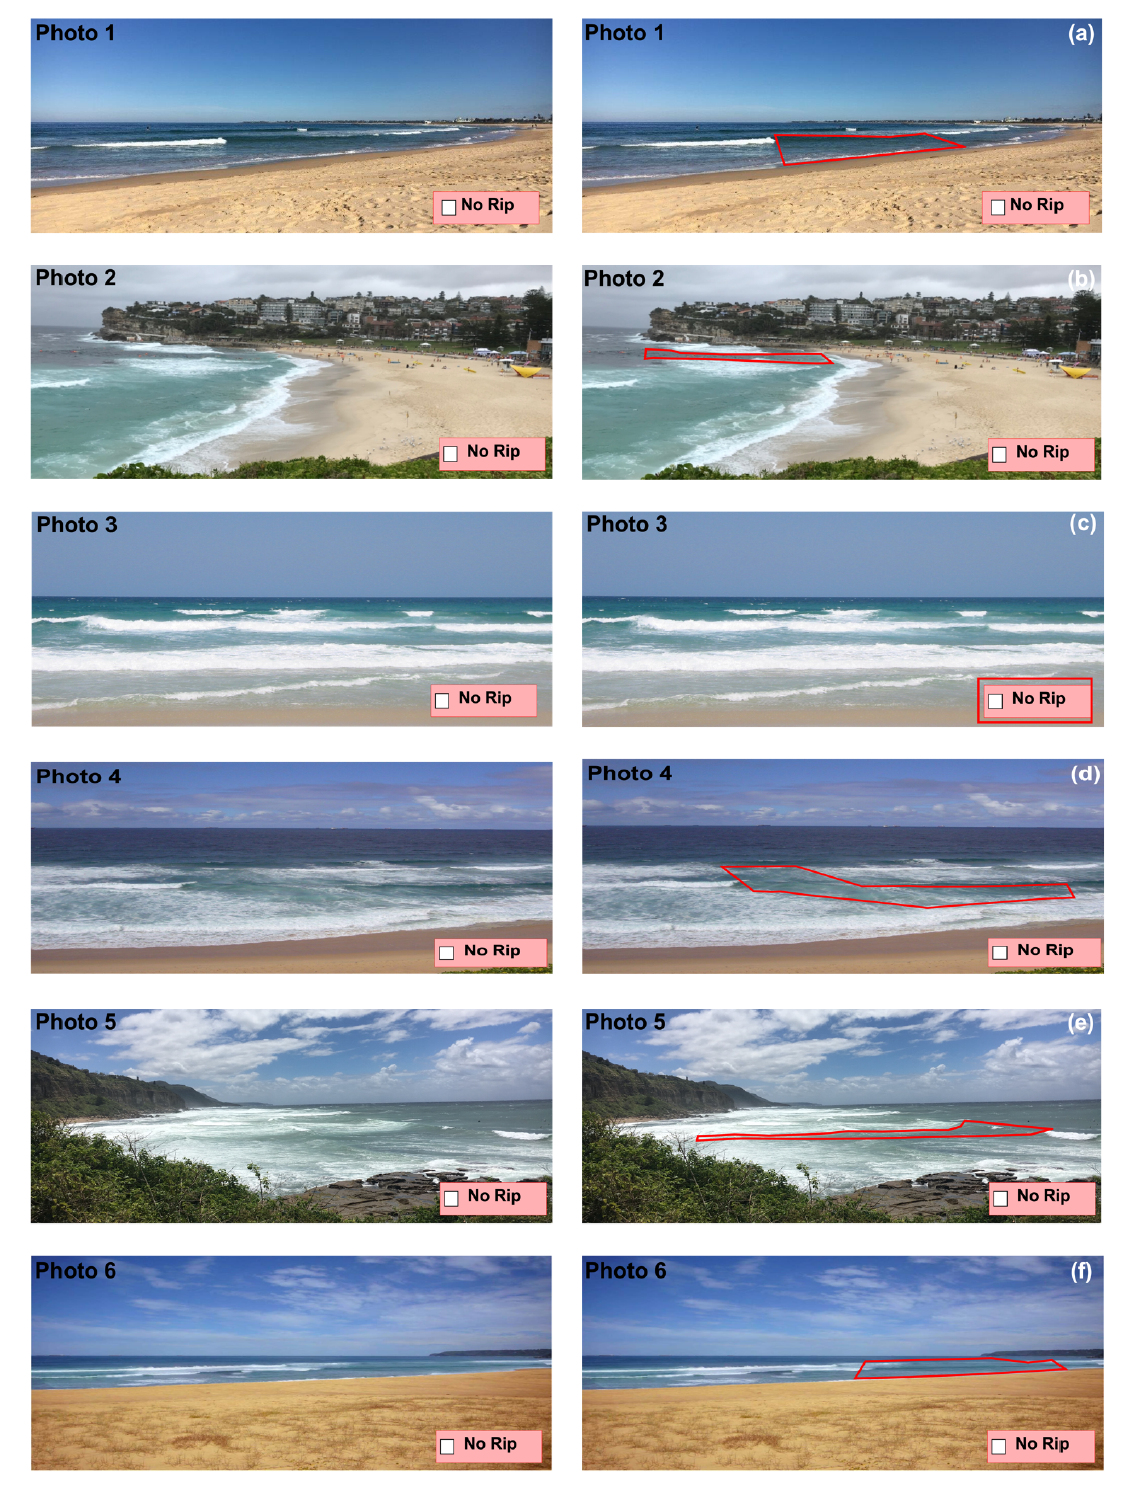
Figure 6. Images that were used to assess beachgoers’ ability to identify rip currents in photos. The polygons on the right side (red area) highlight the location of the rip current. If respondents placed an “x” within these areas, they were correct. Photos 1 and 2 (a, b) and 4–6 (d–f) contain a rip current while Photo 3 (c) does not. During the survey, respondents were shown the photos on the left with no polygons and the size of the rip photos was larger as they were shown on a 20 × 15cm tablet screen and only one photo was presented at a time. The pre- determined polygons already include a small buffer to avoid possible unwanted incorrect responses. Photos courtesy of Robert W. Brander. https://doi.org/10.5194/nhess-22-909-2022 Nat. Hazards Earth Syst. Sci., 22, 909–926,